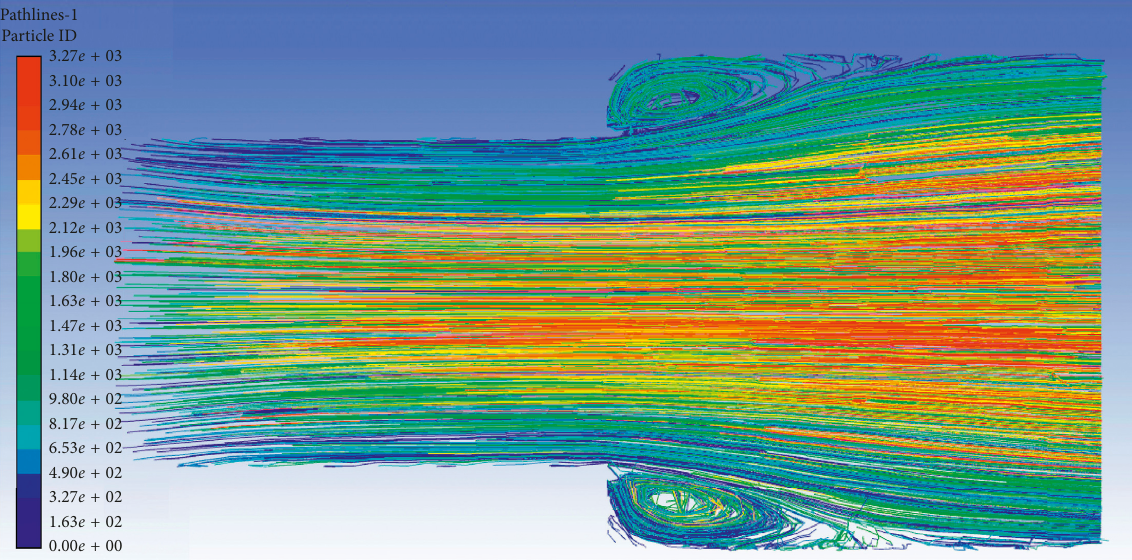
Figure 9: Sudden extension ratio is 1.5.